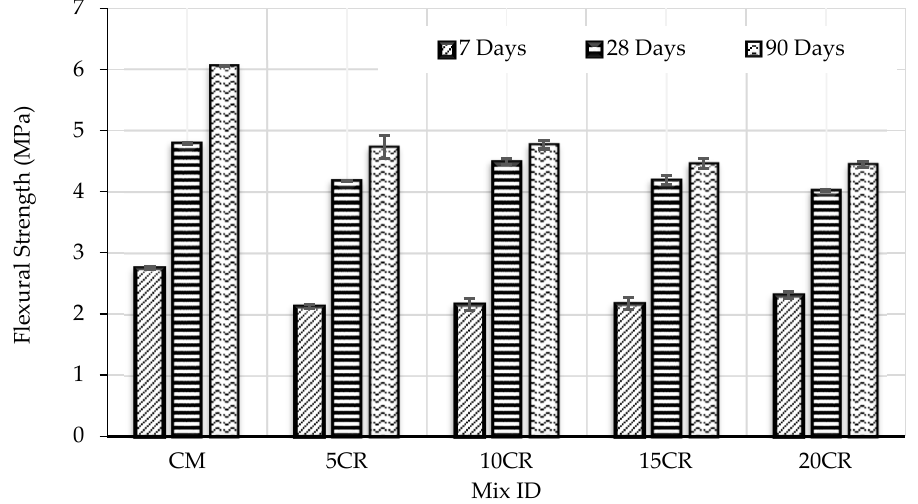
Figure 13. The average flexural strength of rubberized concrete.